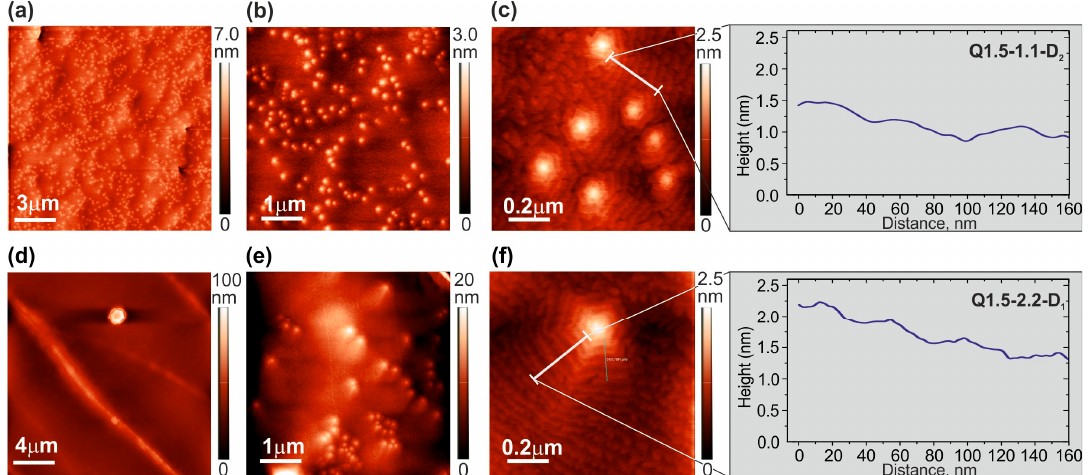
Figure 5. AFM images of the surfaces of MQW structures Q1.5-1.1-D 2 ( a – c ) and Q1.5-2.2-D 1 ( d – f ) grown on D i -type templates. The AFM images were measured with various scan areas ranging from 1 × 1 µm 2 to 20 × 20 µm 2 . Inserts in figures ( c , d ) depict changes in the profile height along the white line segments plotted on these figures.